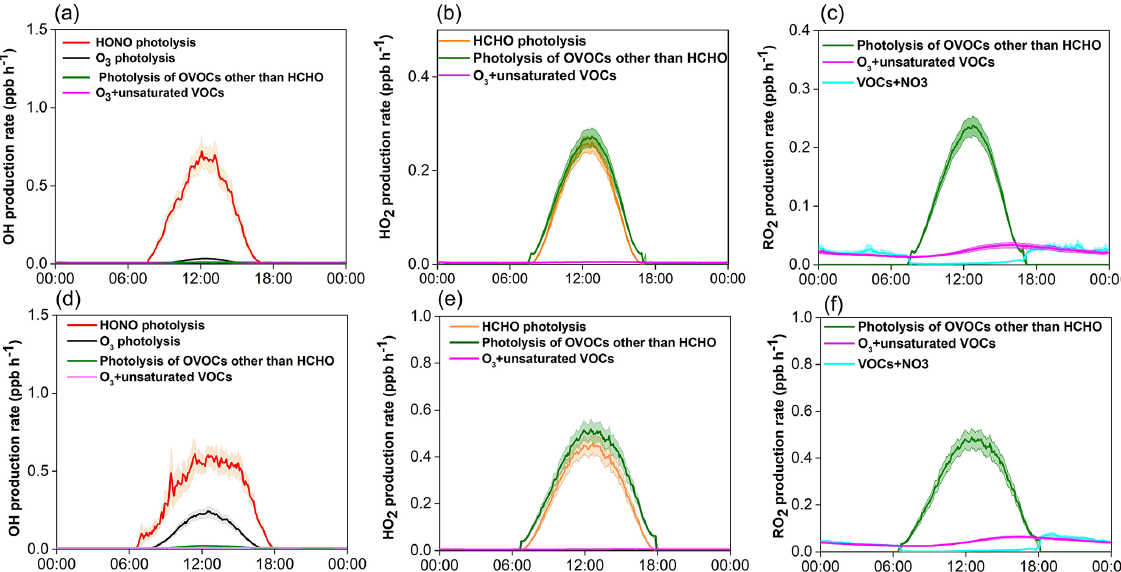
Figure 7. Model-simulated average diurnal variations of major primary sources of OH, HO 2 , and RO 2 at Mt. Tai in winter (a, b, c) and spring (d, e, f) . Shaded area indicates the standard error of the data.